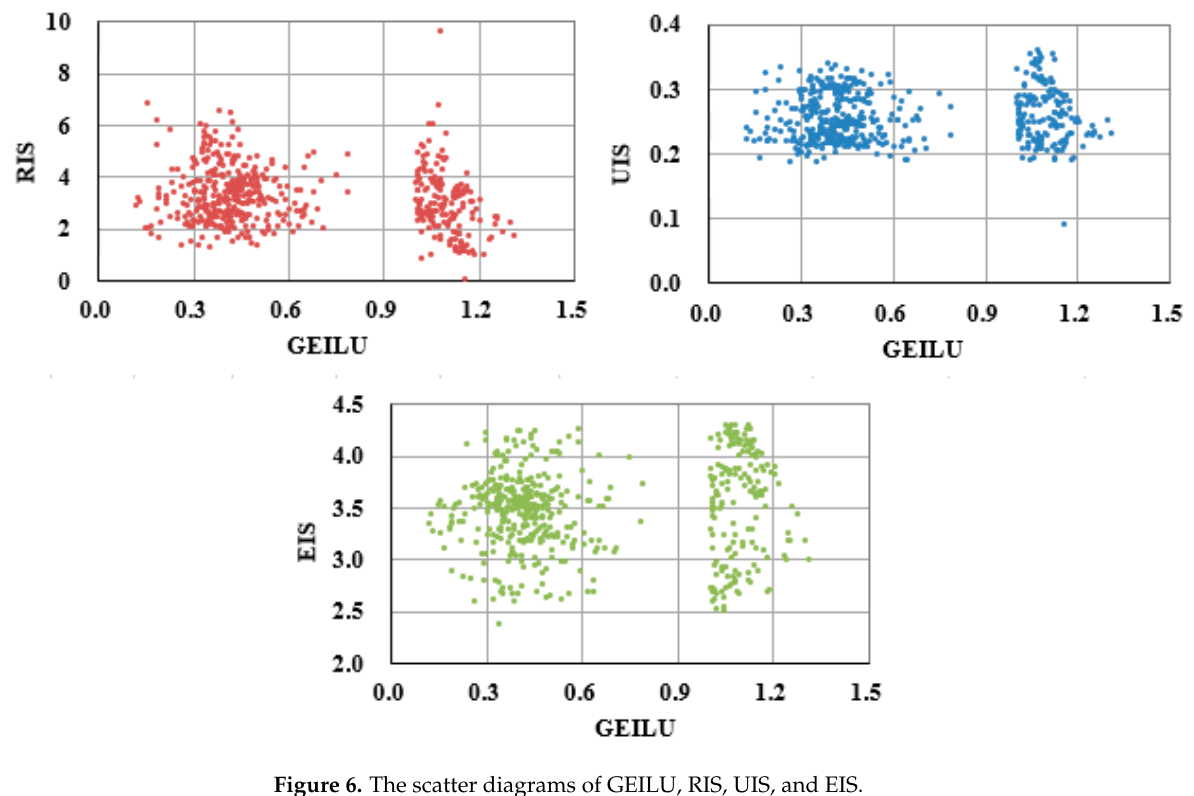
Figure 6. The scatter diagrams of GEILU, RIS, UIS, and EIS.